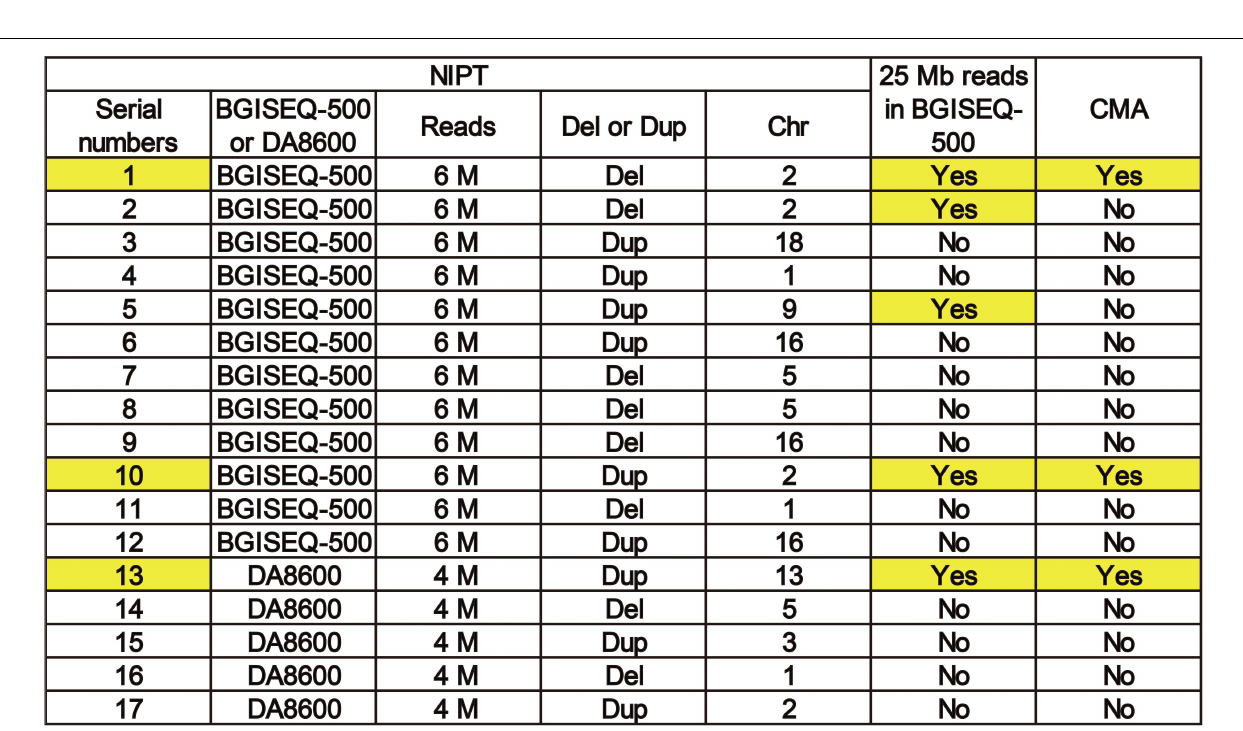
FIGURE 4 | A list of 17 cases that met the requirements for re-sequencing at 25 M reads on theBGISEQ-500 sequencing platform.